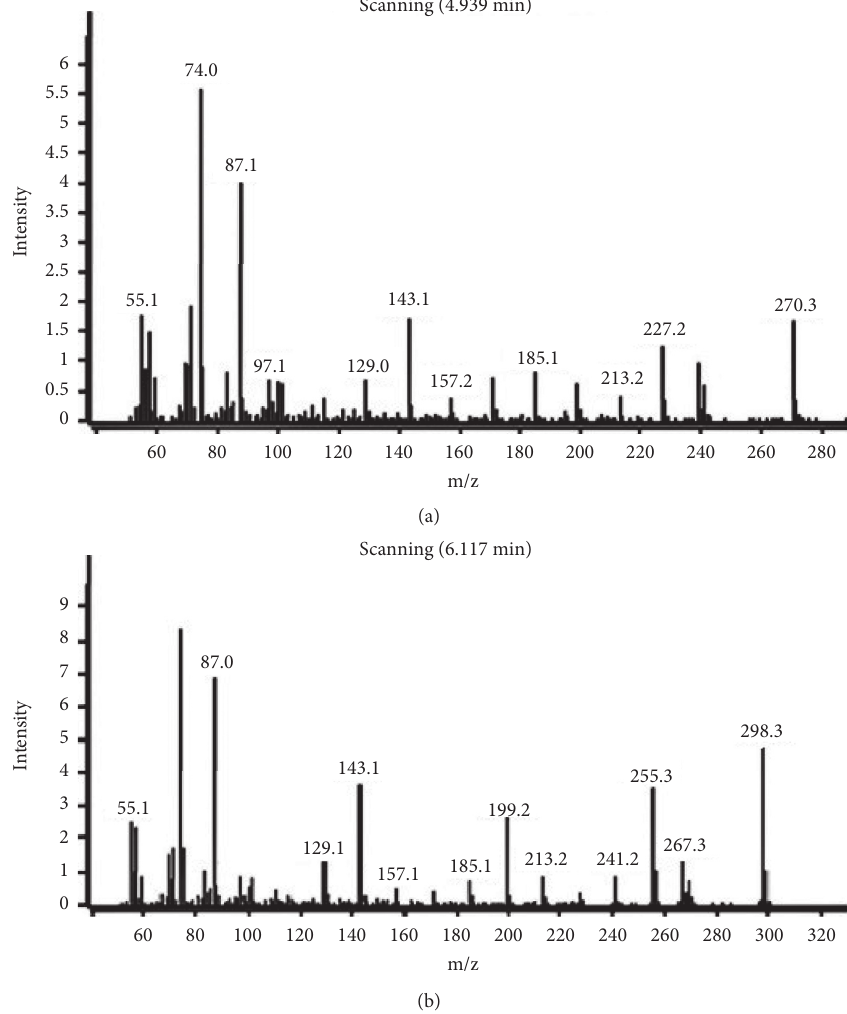
Figure 1: Mass spectrum of methyl hexadecanoate (a) and methyl stearate